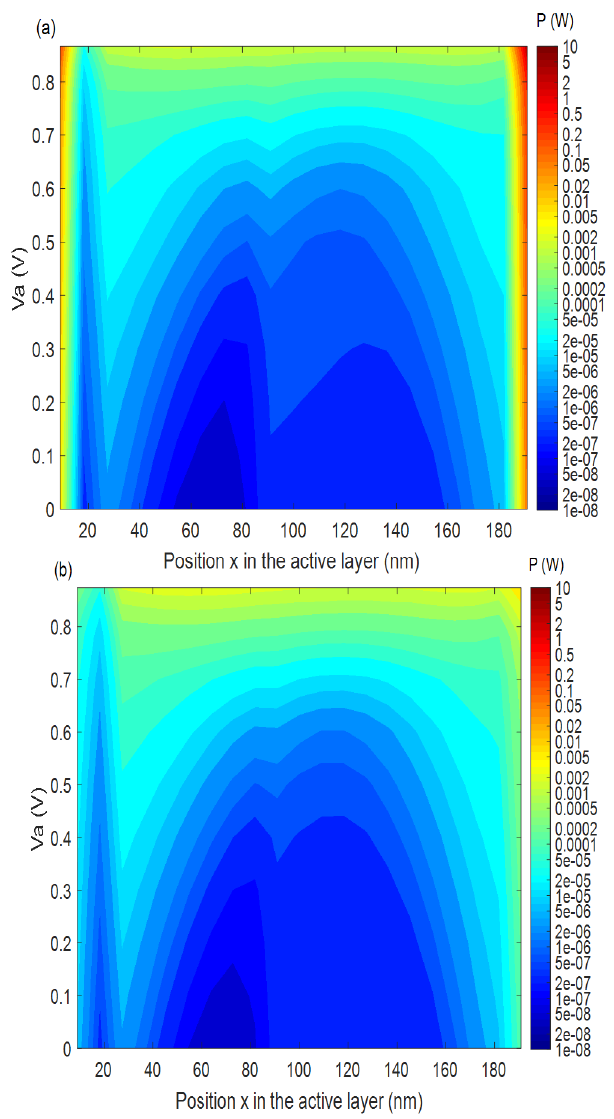
Figure 7. The contour plot of heat generation rate due to the non-radiative recombination as a function of position x in the active layer and applied voltage V a with ( a ) N ti = 10 18 and ( b ) N ti = 10 15 m − 3 ( eV ) − 1 .